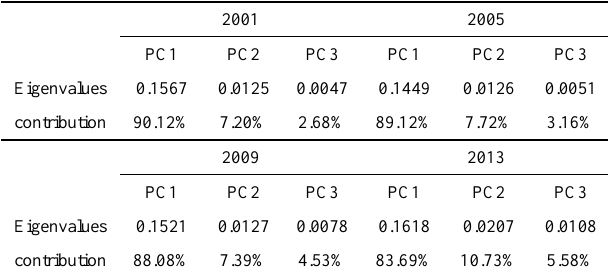
Table 1. Eigenvalues and contribution of three index